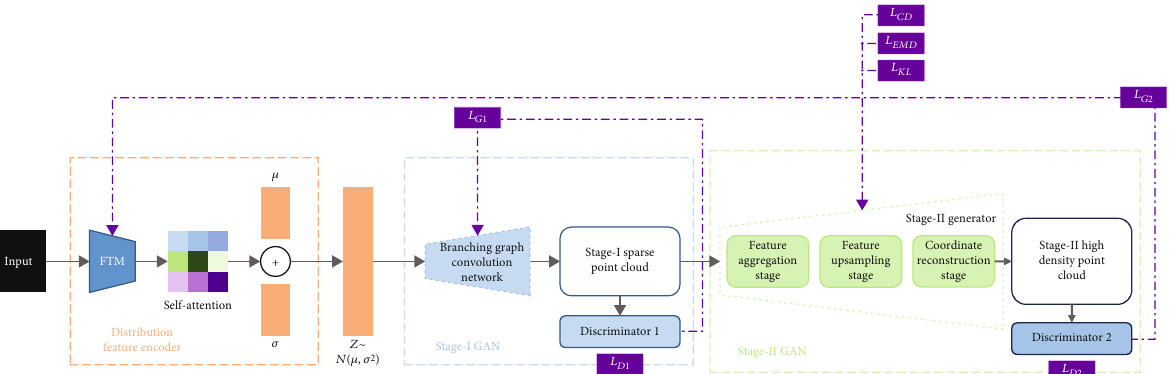
Figure 1: The architecture of the proposed model.